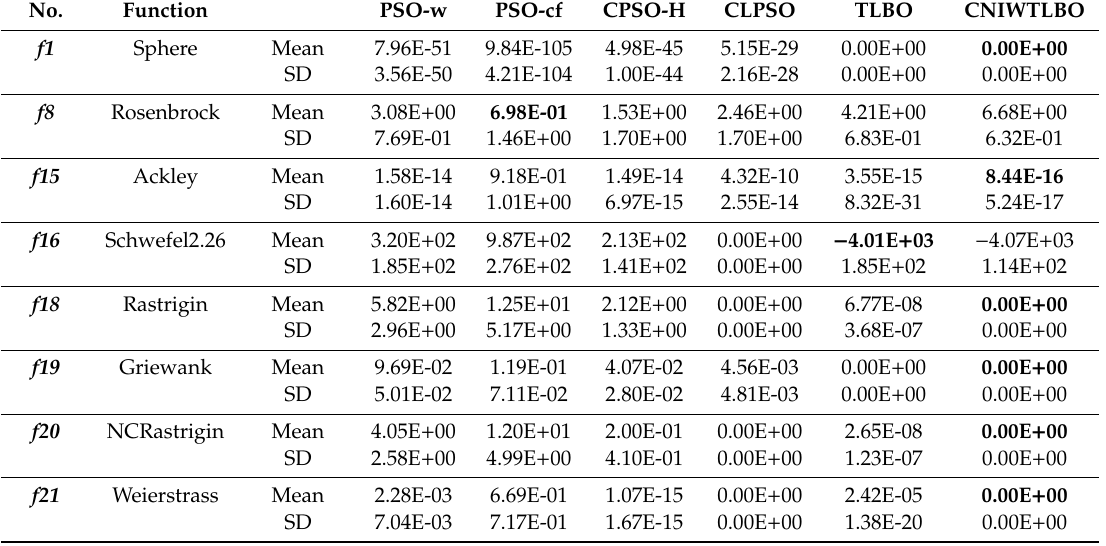
Table 5. Comparative results of CNIWTLBO and other variants of